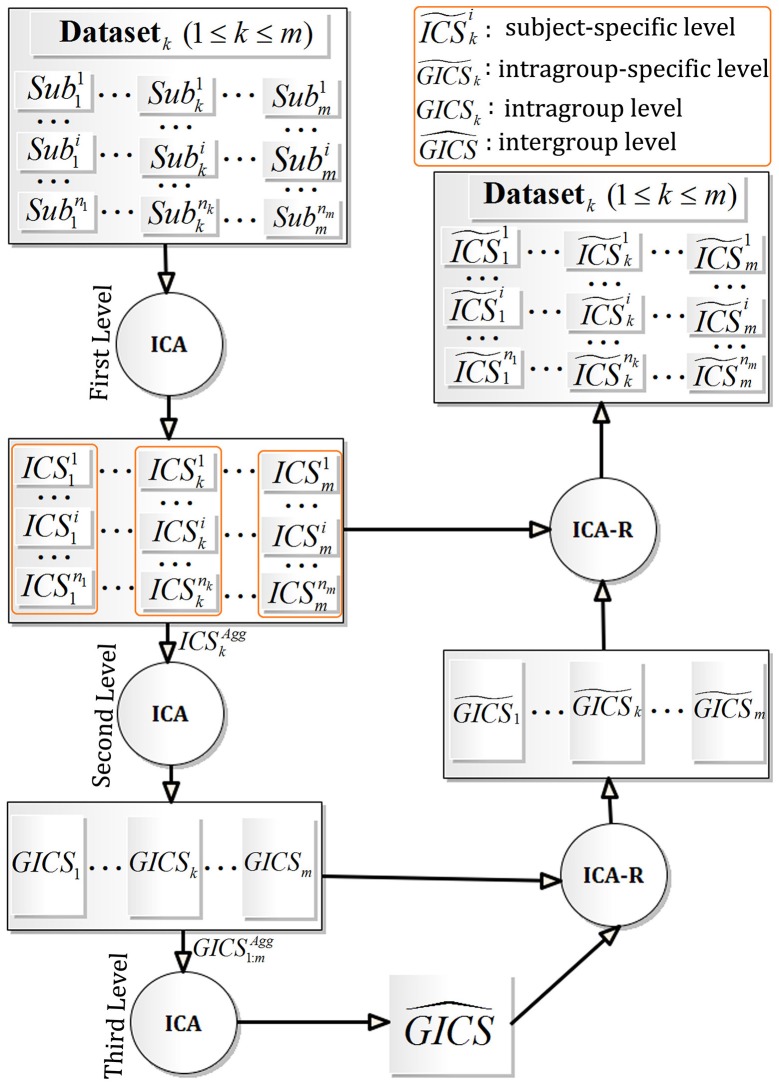
Framework of FMICA.